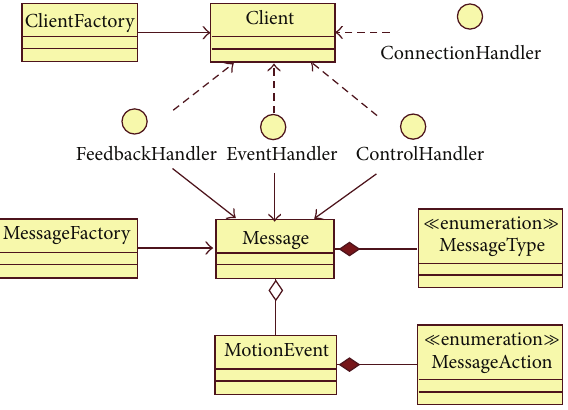
Figure 5: API class